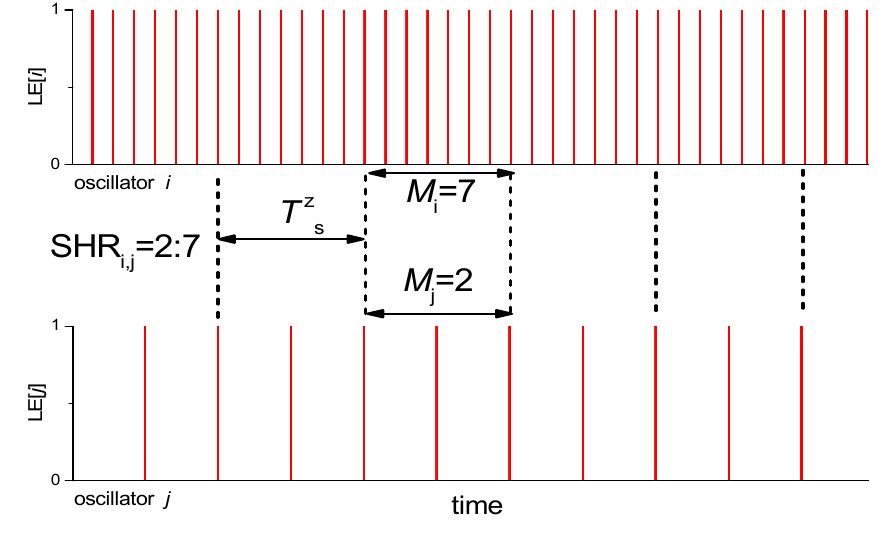
Figure 6. Arrays LE[ i ] and LE[ j ] for two oscillators.